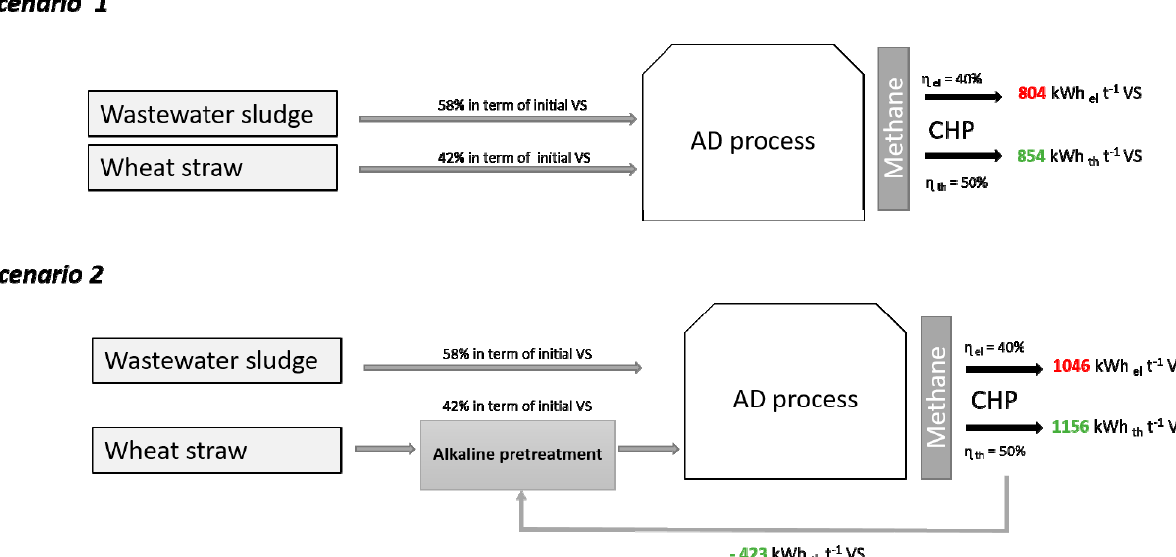
Figure 8. Energy and economical balances between Scenario S1 (control WS) and S2 (alkaline-pretreated WS).